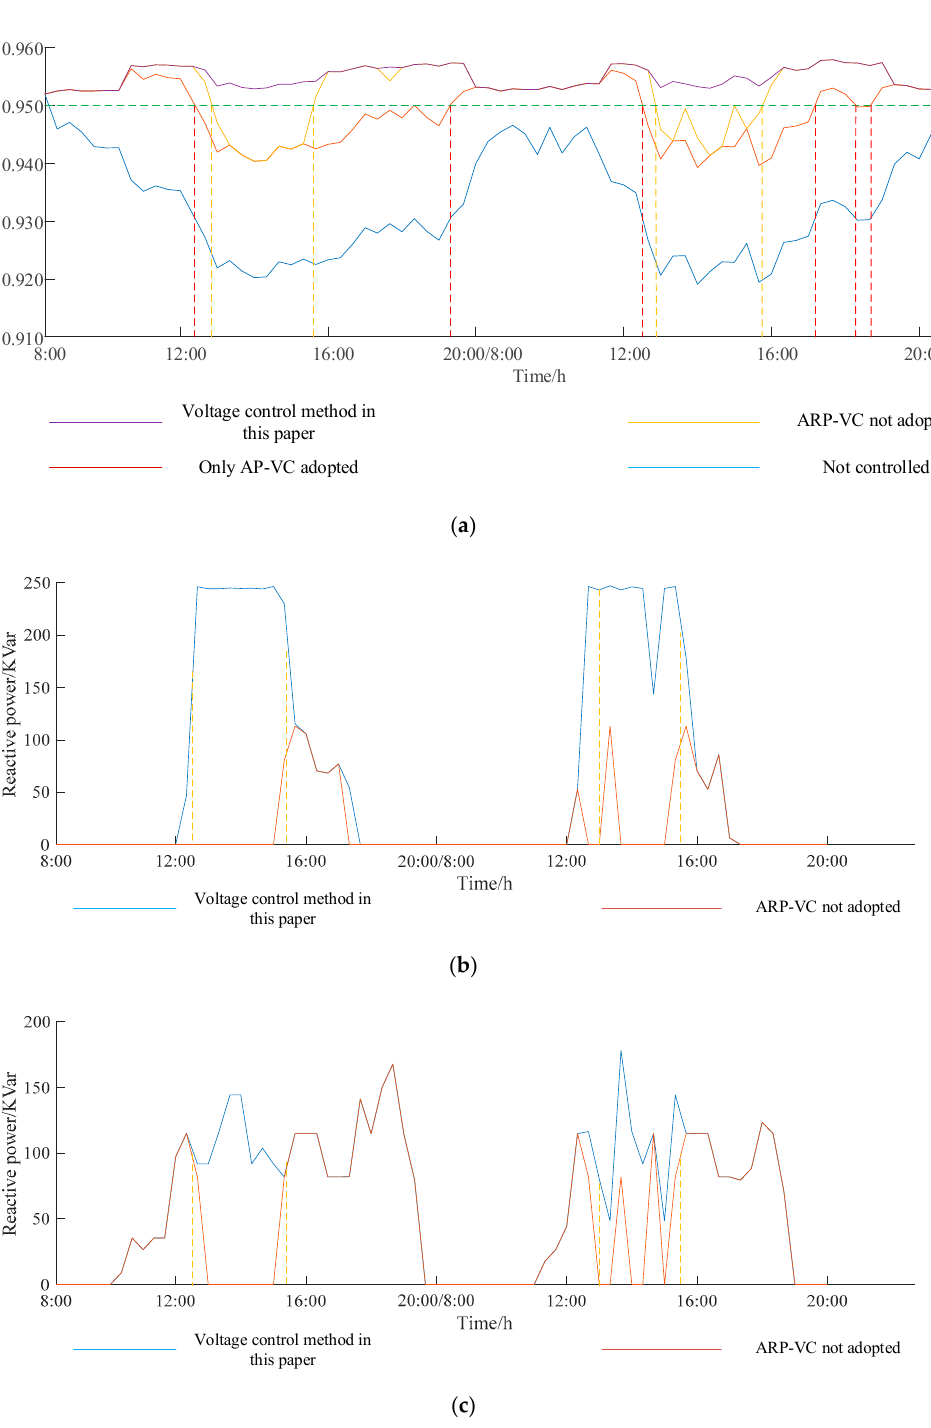
Figure 13. Control effects of AR 3: ( a ) voltage of bus 31 when controlled differently; ( b ) reactive power change of wind turbine 28; and ( c ) reactive power change of wind turbine 33.